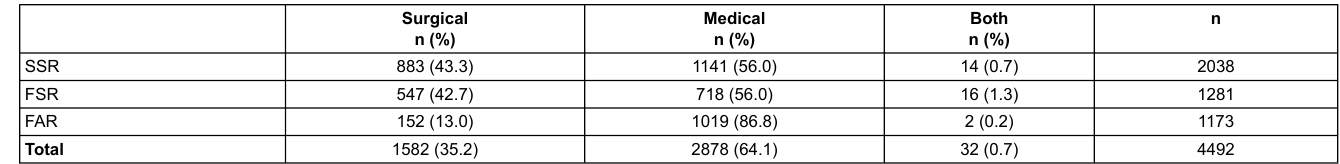
Table 3: VTP method chosen (2008–2015).